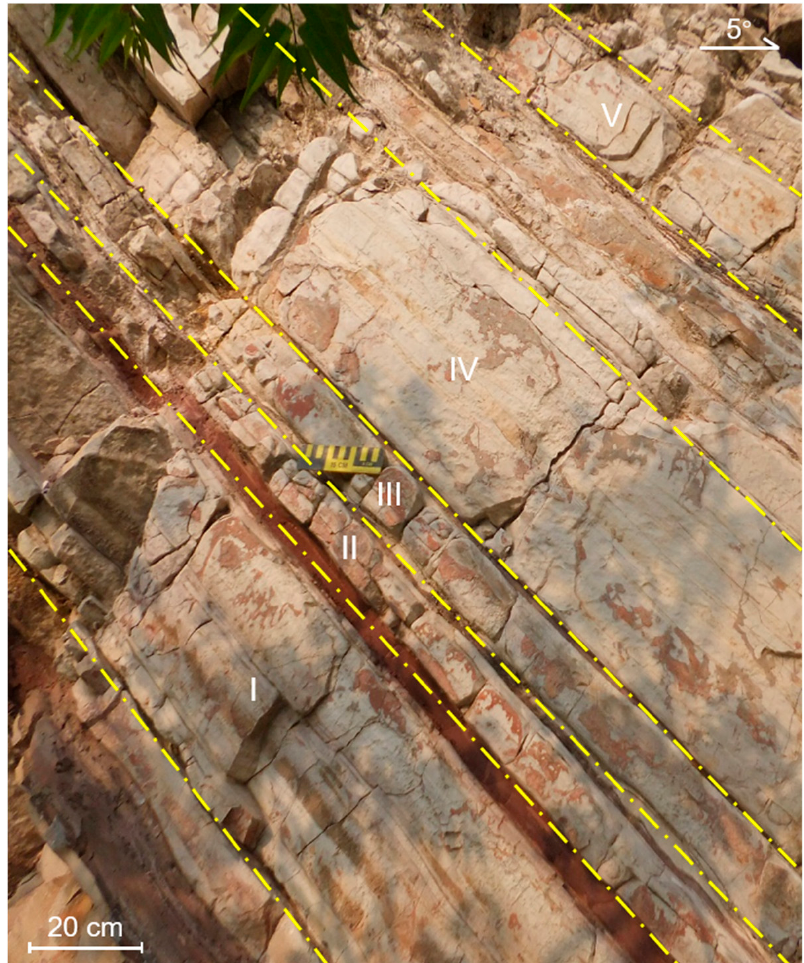
Figure 14. The outcrop section shows tectonic fractures in different mechanical units. I to V refer to the number of mechanical units. The linear density of tectonic fractures is 4.3 m − 1 in I, 10.6 m − 1 in II, 9.3 m − 1 in III, 3.6 m − 1 in IV, and 6.7 m − 1 in V.